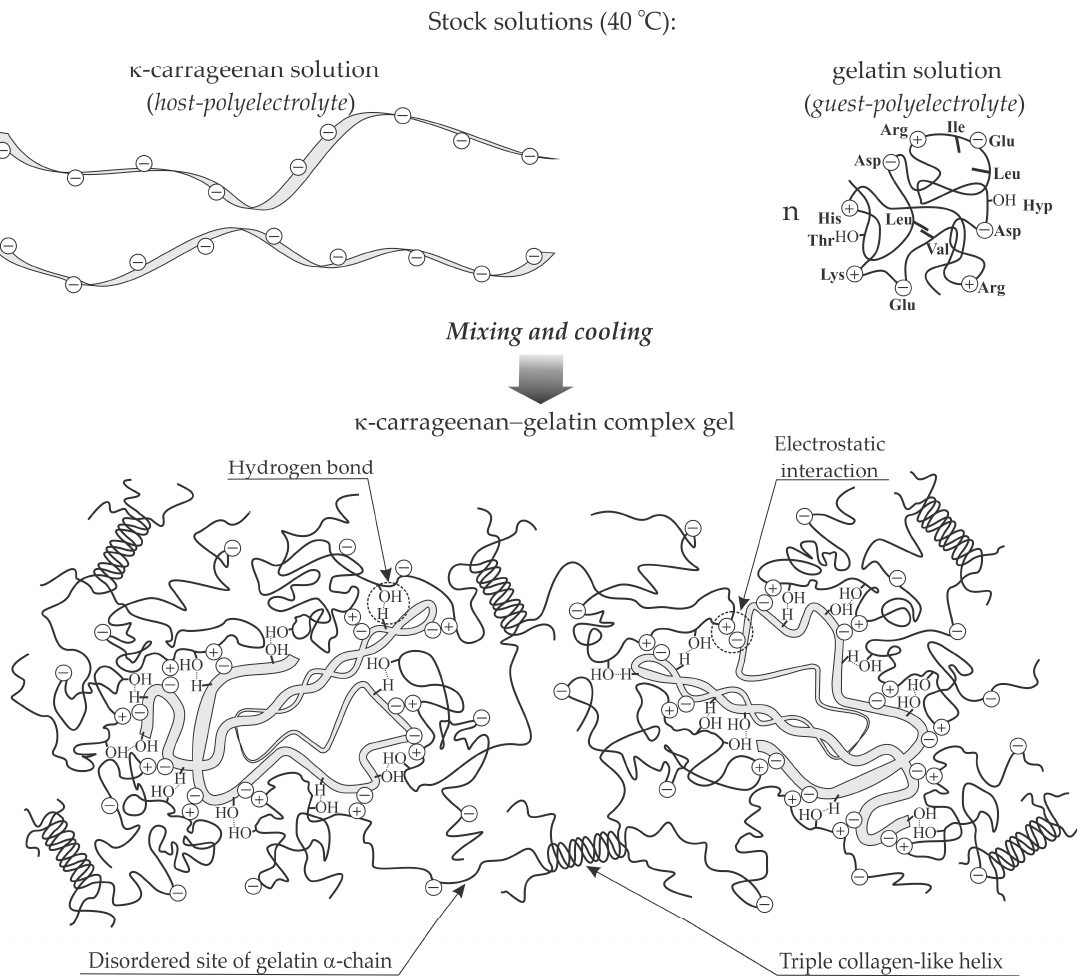
Figure 2. Schematic model of the formation of a complex κ -carrageenan–gelatin gel network.